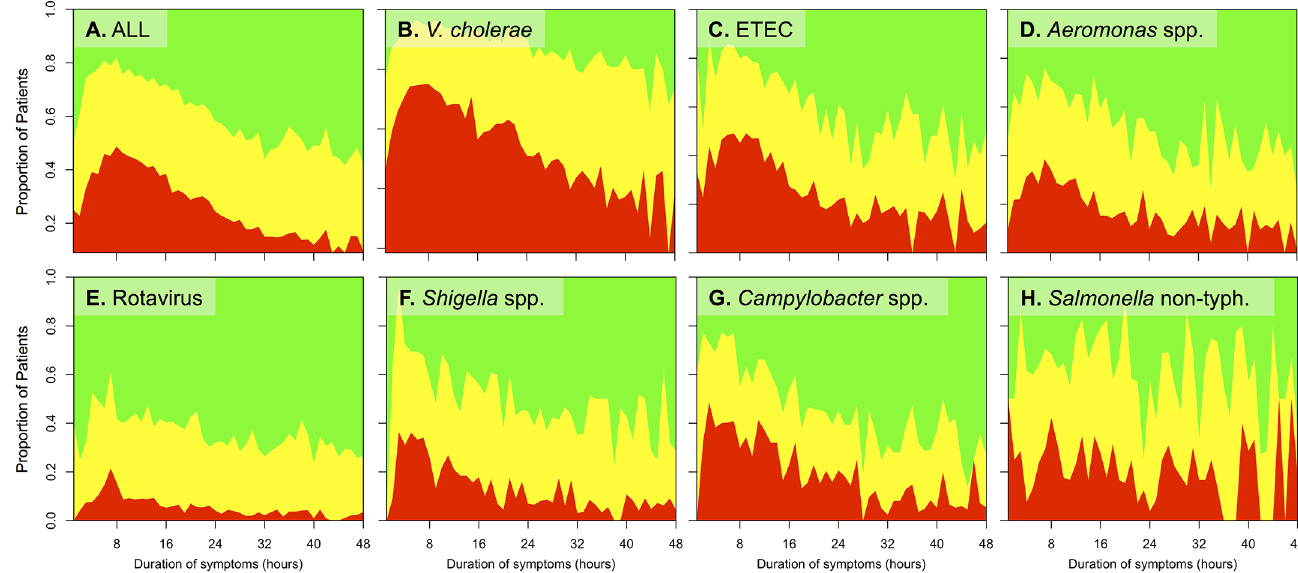
Fig 5. Dehydration status as a function of symptom duration prior to presentation. The proportionof patients with severe (red), some (yellow), and no (green)dehydrationare shown for all patients (A) or patients with a specific pathogen(B-H).